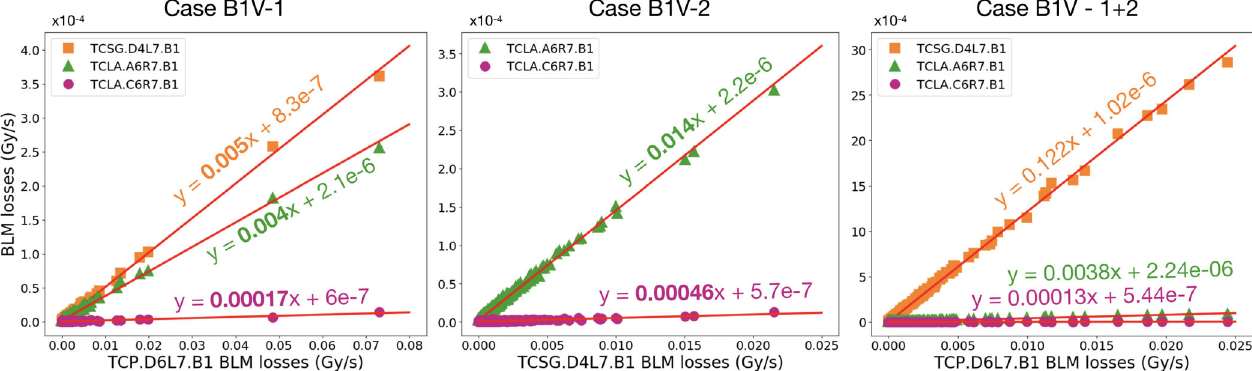
FIG. 6. The 100 Hz BLM signals recorded using the three configurations of closed collimators in Fig. 4, against the 100 Hz BLM signal of the first upstream collimator closed within the configuration. Linear fits were applied to each set of data points, and the gradients obtained using the individual case configurations are marked in